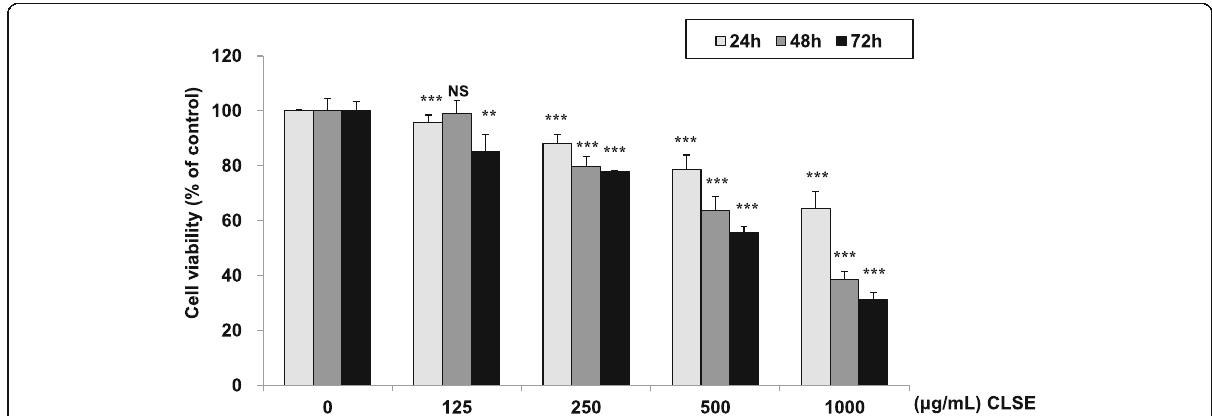
Fig. 1 Cytotoxic effect of Coix lacryma-jobi sprout extract (CLSE) on HeLa cells. Cell viability was assessed by the Cell Counting Kit-8 after treatment with different concentrations of CLSE (0 – 1000 μ g/mL) for 24 – 72 h. ** p < 0.01 and *** p < 0.001 versus control group. NS, not significant. All data values are expressed as the mean ± standard deviation ( n =